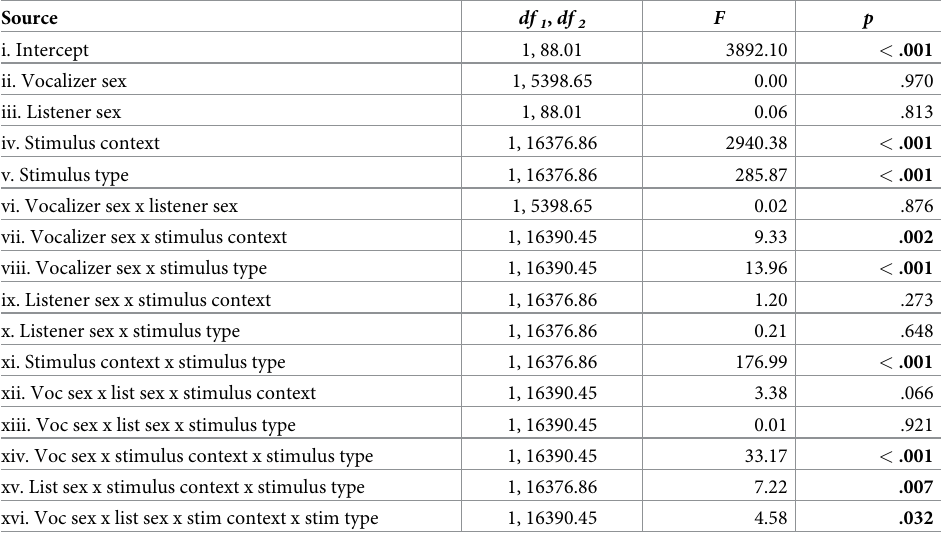
Table 3. Strength attributions: Linear mixed model testing the effects of vocalizer sex, listener sex, stimulus con- text, and stimulus type on rated strength. Source df 1 , df